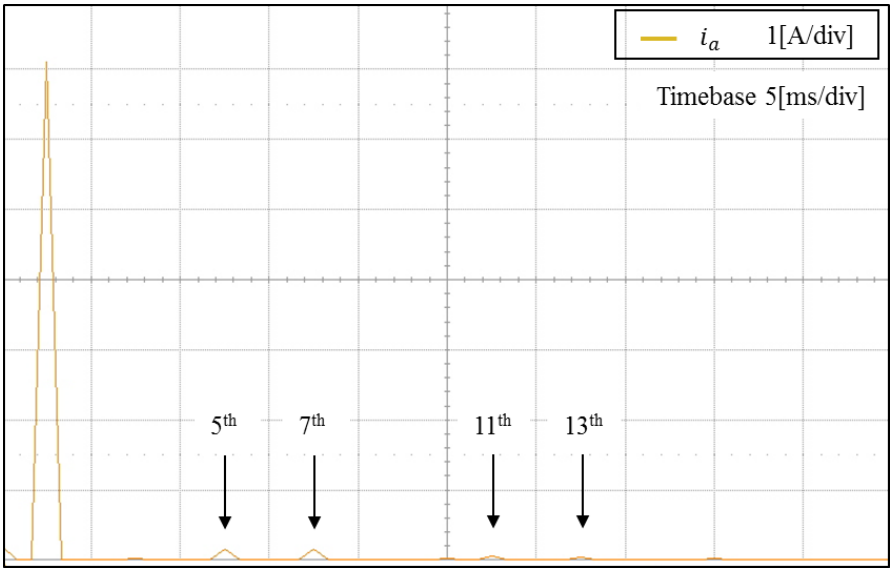
Figure 24. FFT result of a -phase current using the proposed control scheme under the distorted grid voltages.